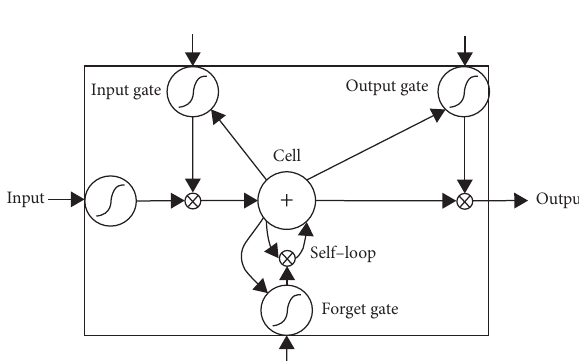
Figure 3: Examples of the optical flow dataset.